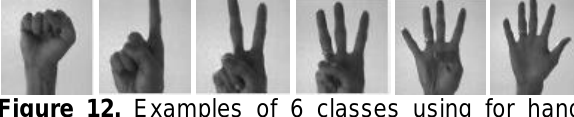
Figure 12. Examples of 6 classes using for hand poses classification on